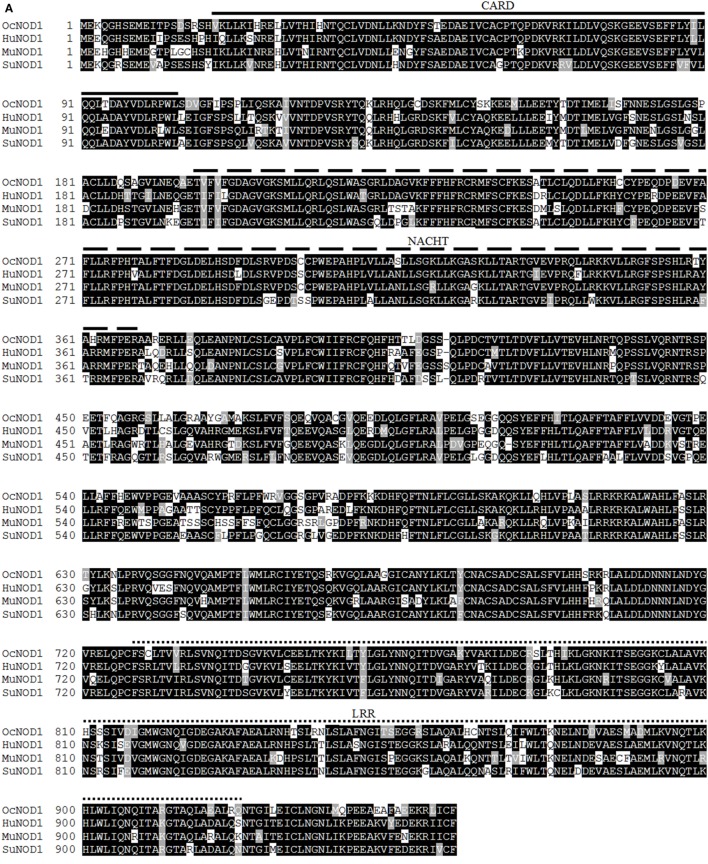
Sequence analysis of rabbit nucleotide-binding oligomerization domain 1 (rNOD1). (A) Alignment of amino acid sequence in Oryctolagus curiculus (MF069503), Homo sapiens (NP_006083.1), Mus musculus (NP_ 766317.1), and Sus scrofa (NP_001107749.1) NOD1. Alignment was performed using Clustal X and edited with Boxshade. Black shading indicates amino acid identity; gray shading indicates similarity (50% threshold). The caspase activation and recruitment domain (CARD), NACHT, and leucine-rich repeat (LRR) domains were indicated in this figure. (B) Protein motifs of rNOD1 were analyzed using sample modular architecture research tool (SMART). (C) A phylogenic tree based on rNOD1 between O. curiculus and other species. A neighbor-joining tree was generated using MEGA 5.0, and a 1,000-bootstrap analysis was performed. The sequences used were: Equus caballus NOD1, XP_001499616.1; Equus przewalskii NOD1, XP_008521180.1; Equus asinus NOD1, XP_014696539.1; Sus scrofa NOD1, NP_001107749.1; Ovis aries NOD1, XP_ 004007979.1; Pantholops hodgsonii NOD1, XP_005981278.1; Ailuropoda melanoleuca NOD1, XP_002919315.1; Canis lupus NOD1, XP_013974566.1; Homo sapiens NOD1, NP_006083.1; Papio anubis NOD1, XP_003896196.1; Macaca nemestrina NOD1, XP_011729625.1; Macaca fascicularis NOD1, XP_005549941.1; Macaca mulatta NOD1, XP_001085719.1; Mus musculus NOD1, NP_ 766317.1; Rattus norvegicus NOD1, NP_001102706.1; Oryctolagus curiculus NOD1, MF069503; Columba livia NOD1, XP_005510067.1; Gallus gallus NOD1, NP_001305367.1; Anas platyrhynchos NOD1, NP_001297310.1; Anser cygnoides NOD1, XP_013053223.1; Ctenopharyngodon idella NOD1, ACX71752.1; Oncorhynchus mykiss NOD1, AII73558.1; Epinephelus coioides NOD1, AFV53357.1; Paralichthys olivaceus NOD1, AFD29894.1.